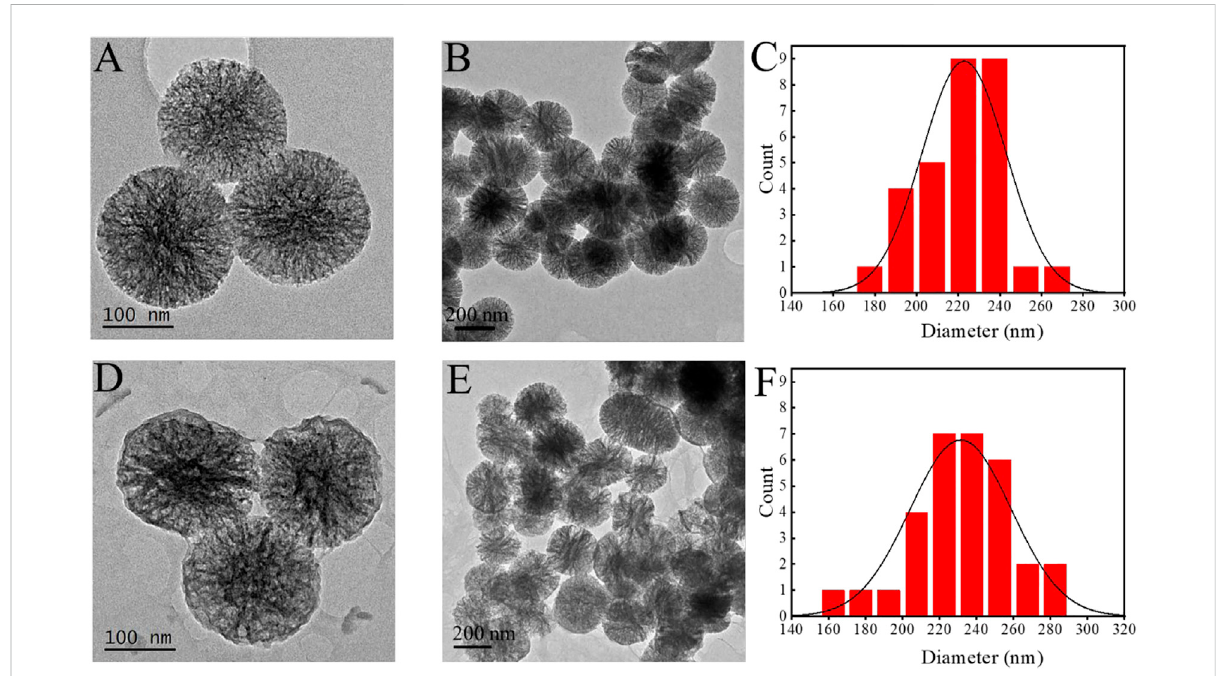
FIGURE 2 TEM images of MBG (A,B) and MBG@ALG (D,E) . Particle size analysis of MBG (C) and MBG@ALG (F)